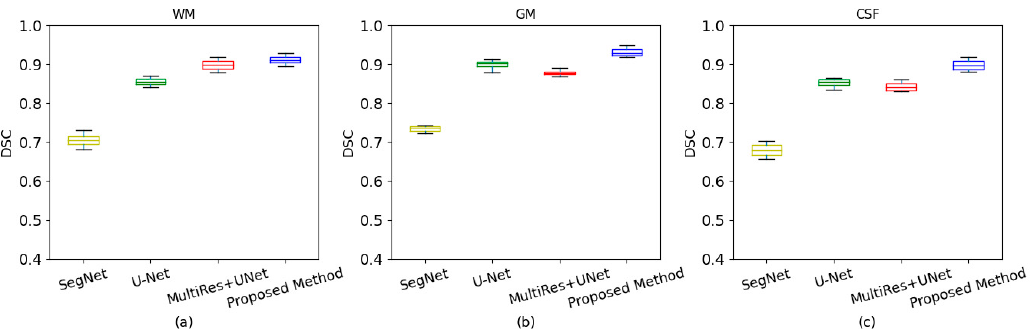
Figure 7. Box plots with different segmentation methods. ( a ) White matter of dice coefficient; ( b ) gray matter of dice coefficient; ( c ) cerebrospinal fluid of dice coefficient.